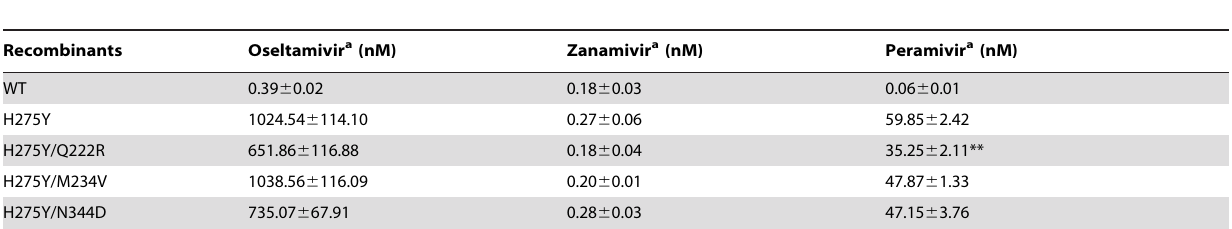
Table 2. Susceptibility profiles of recombinant A/Brisbane/59/2007-like (H1N1) viruses against neuraminidase (NA) inhibitors as assessed by MUNANA NA inhibition